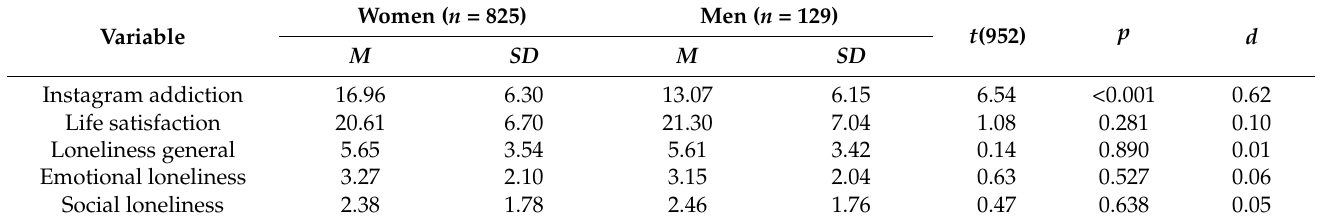
Table 1. Gender differences in Instagram addiction, loneliness, and life satisfaction ( N = 954).